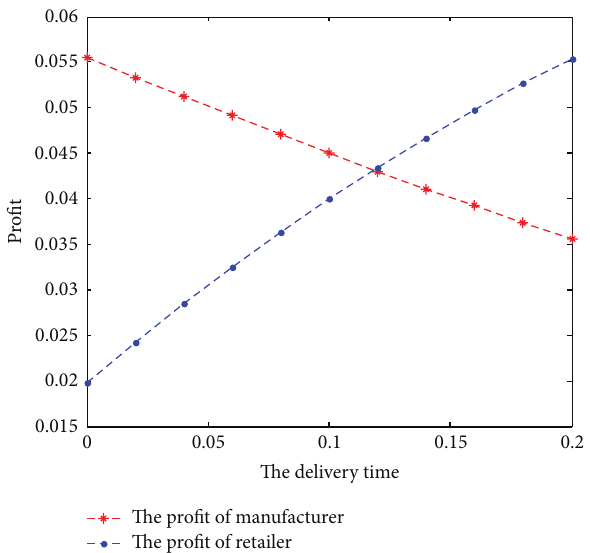
Figure 3: Effect of the delivery time on each player’s profit under Stackelberg game.